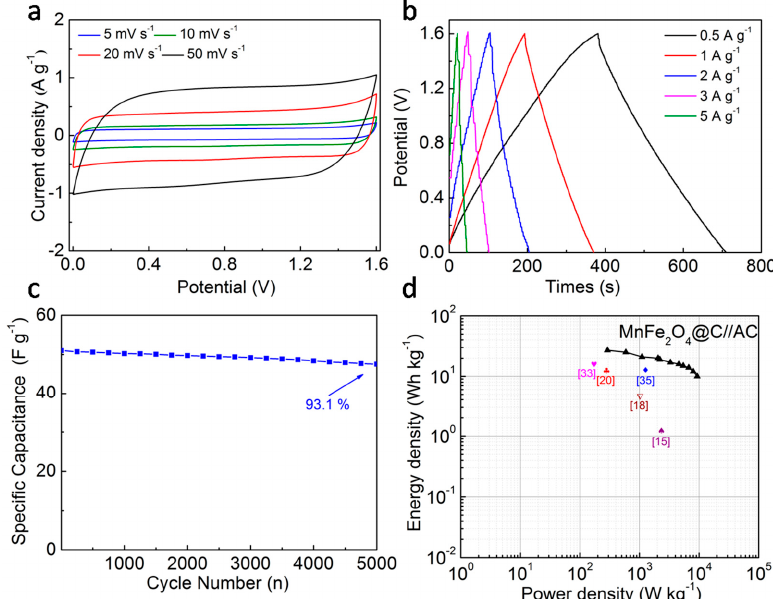
Figure 7. CV curves ( a ), GCD plots ( b ), long-term cycling performance at 1 A·g − 1 ( c ), Ragone plots ( d ) of the MnFe 2 O 4 @C//AC device.